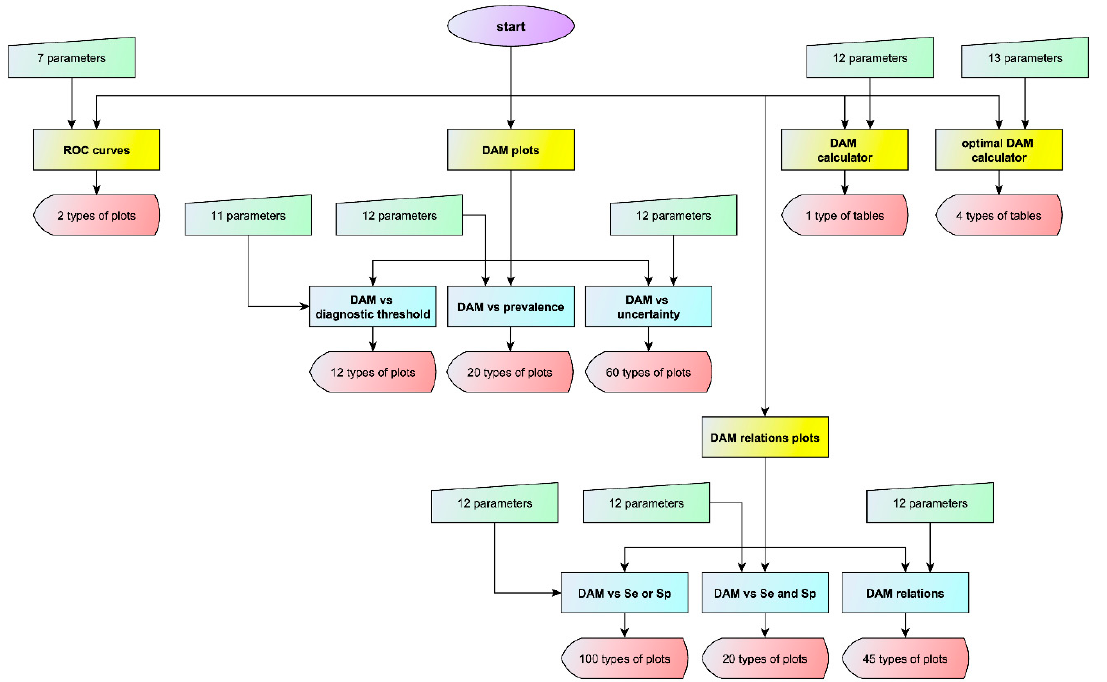
Figure 2. Program flowchart. The flowchart of the program with the number of input parameters and of output types for each module or submodule (DAM: diagnostic accuracy measure).